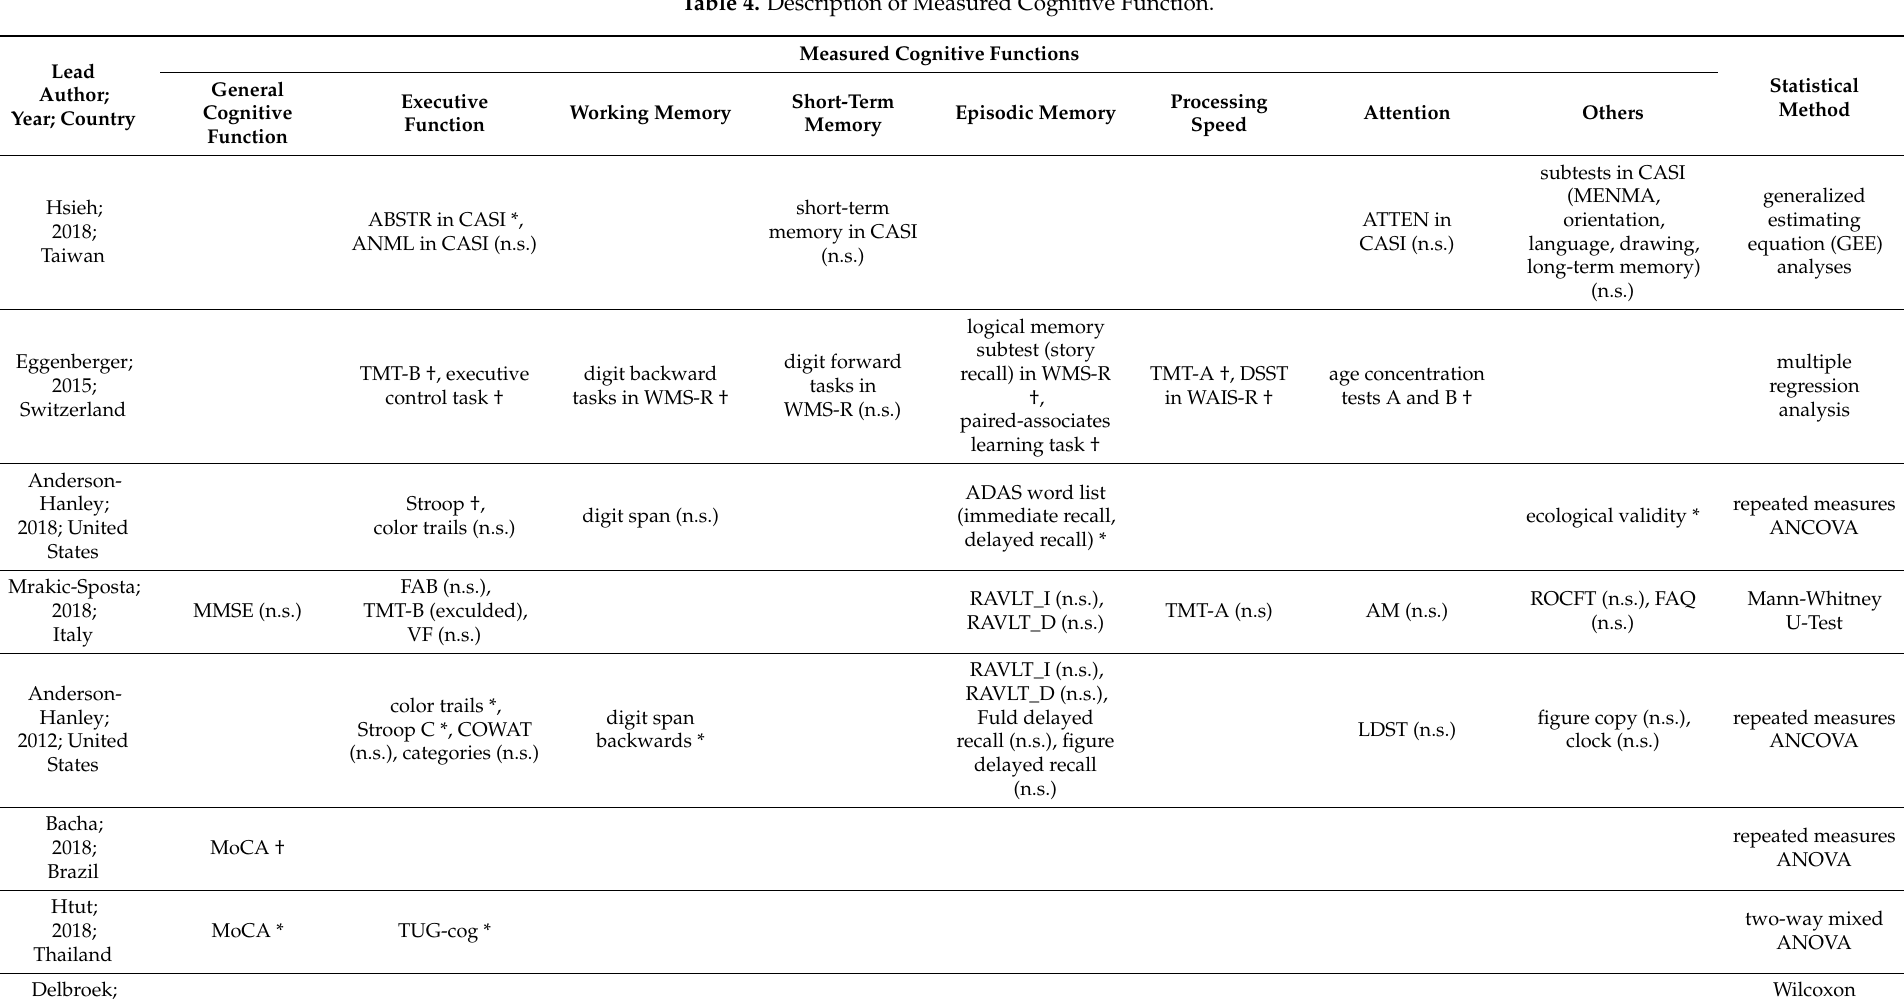
Table 4. Description of Measured Cognitive